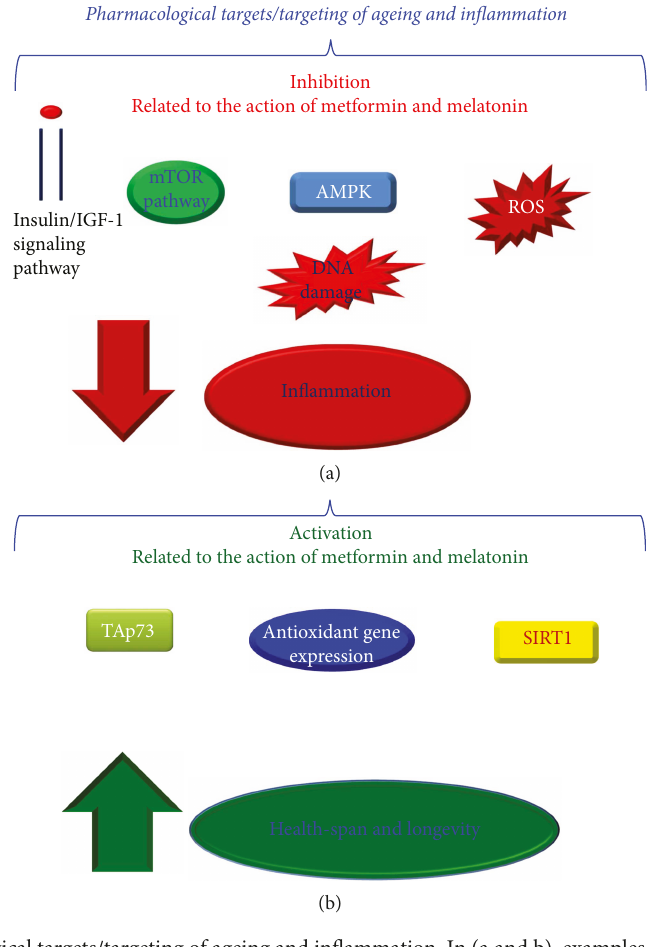
Figure 1: (a and b) Pharmacological targets/targeting of ageing and in fl ammation. In (a and b), examples of ageing and in fl ammatory target pathways. In particular, in (a), it describes the inhibitor actions of metformin and melatonin on ageing/in fl ammatory pathways. In (b), the activation of some ageing/in fl ammatory pathways for counteracting the ageing and in fl ammatory e ff ects and for contributing to health-span and